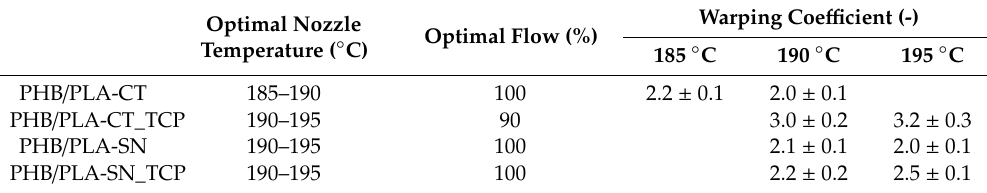
Table 5. Optimized printing conditions and the results of warping test.